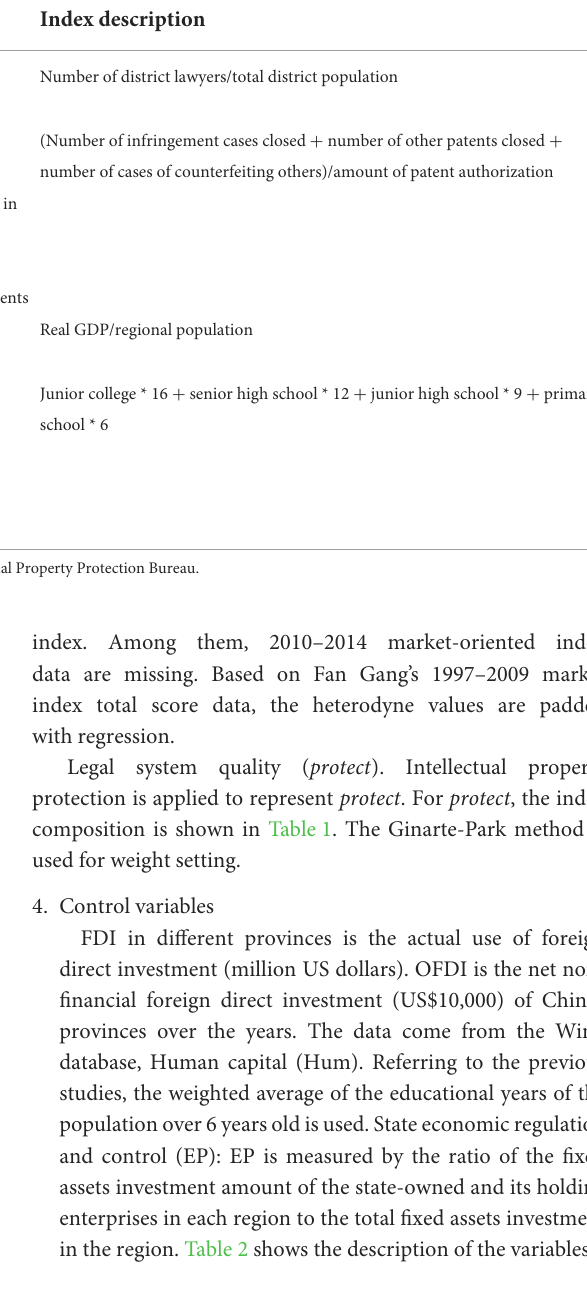
TABLE 1 Legal system quality index